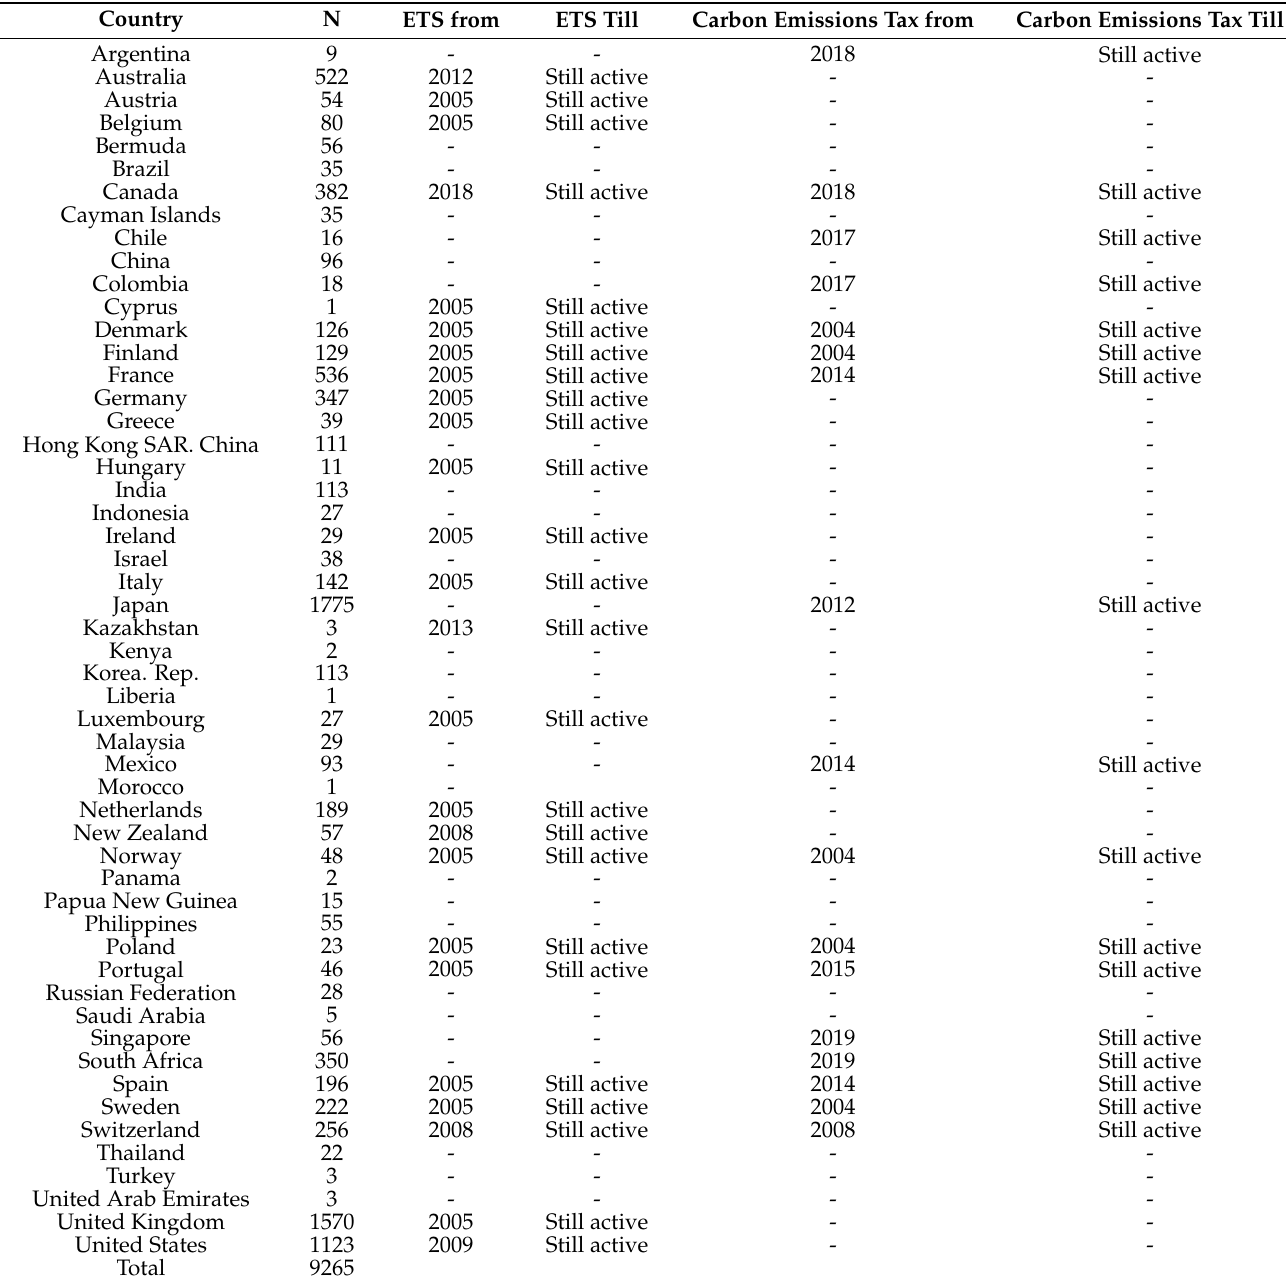
Table A2. Carbon emissions legislation by